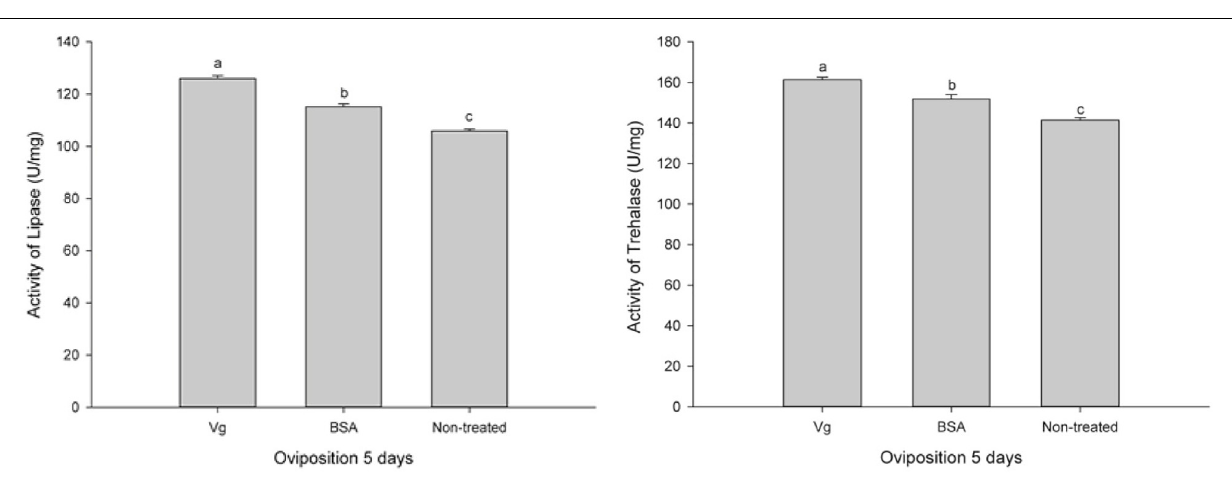
FIGURE 6 | H. axyridis lipase and trehalase activities on the fifth day after female oviposition after treatment with the Vg- and BSA-supplemented artificial diets. The significance of the differences in the enzyme activities were analyzed by SPSS. The enzyme activities as shown as the means ± SEs and were found to be significantly different ( P <